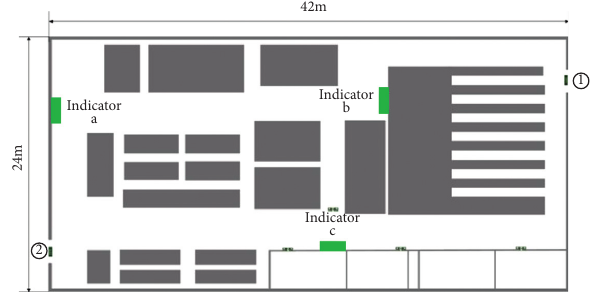
Figure 8: Layout of the factory instructions.